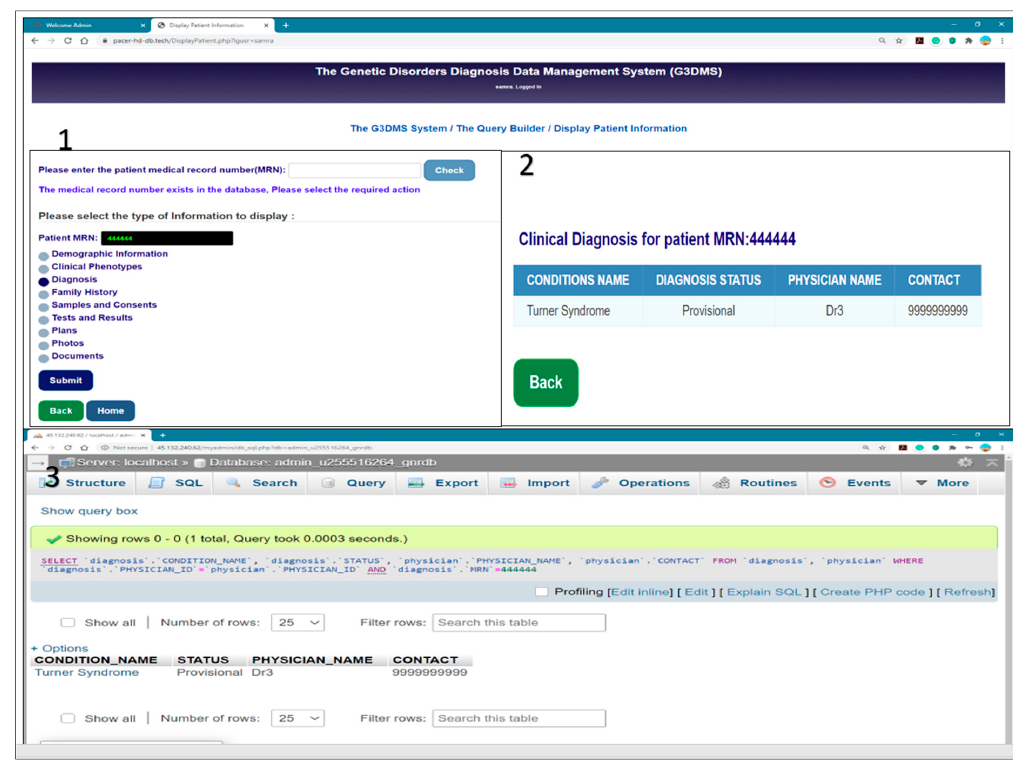
Figure 21. Testing the query (display patient diagnosis information) shows equivalent results.